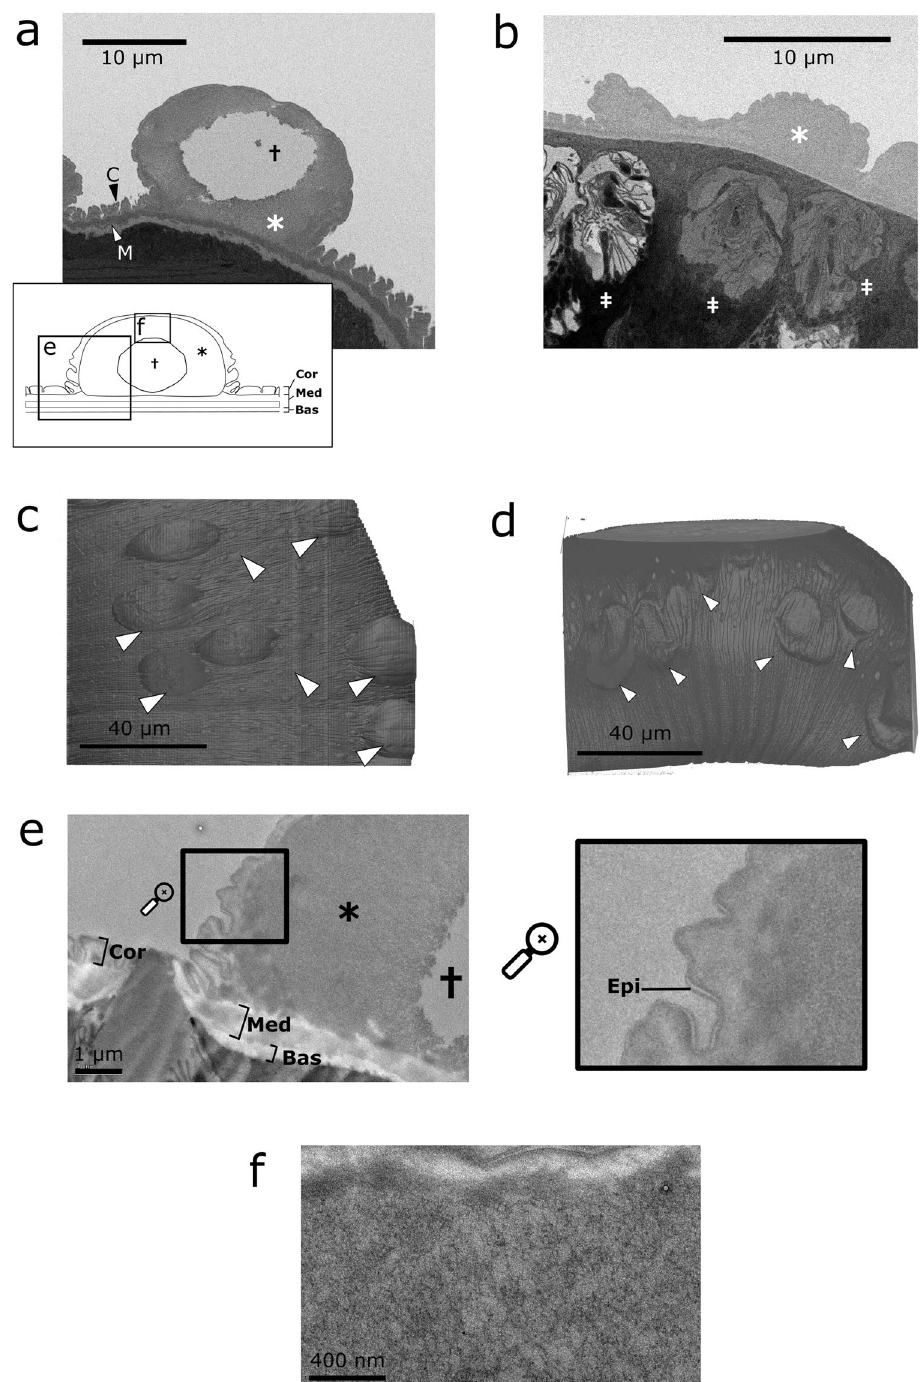
Figure 3. Ultrastructure of cuticular inflations in T. muris shown by SBF-SEM and TEM at day 35 PI. ( a ) backscattered electron micrograph of a cuticular inflation presenting its inflated aspect. The inflation develops between the Median (M) and cortical (C) layers of cuticle, and contains both a further layer of cuticular material ( * ), as well as a void (†). The inset schematic shows the location of the TEM imaging frames shown in ( e , f ). ( b ) Backscattered electron micrograph of a cuticular inflation presenting its collapsed aspect. Packing material is present ( * ), but the void is not. Bacillary cells are present underneath the inflation (‡). ( c ) 3D rendering of the inflated aspect cuticular inflation. ( d ) 3D rendering of the collapsed-aspect inflations. ( e ) TEM micrograph of the cuticular inflation showing the cortical (Cor), basal (Bas), and medial (Med) layers of cuticle. The epicuticle (Epi) is shown in the magnified region. ( f ) the inflation interior layer ( * ) contains a fine web-like network of